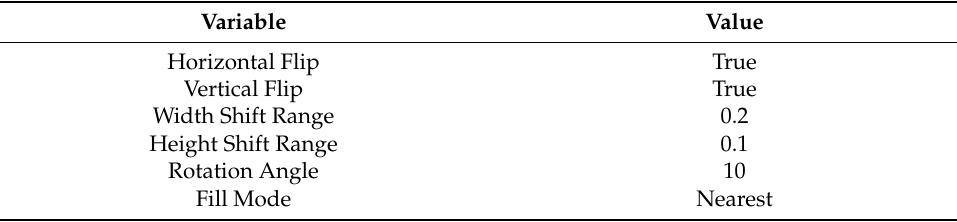
Table 2. Parameters of data augmentation of surface deformation images.